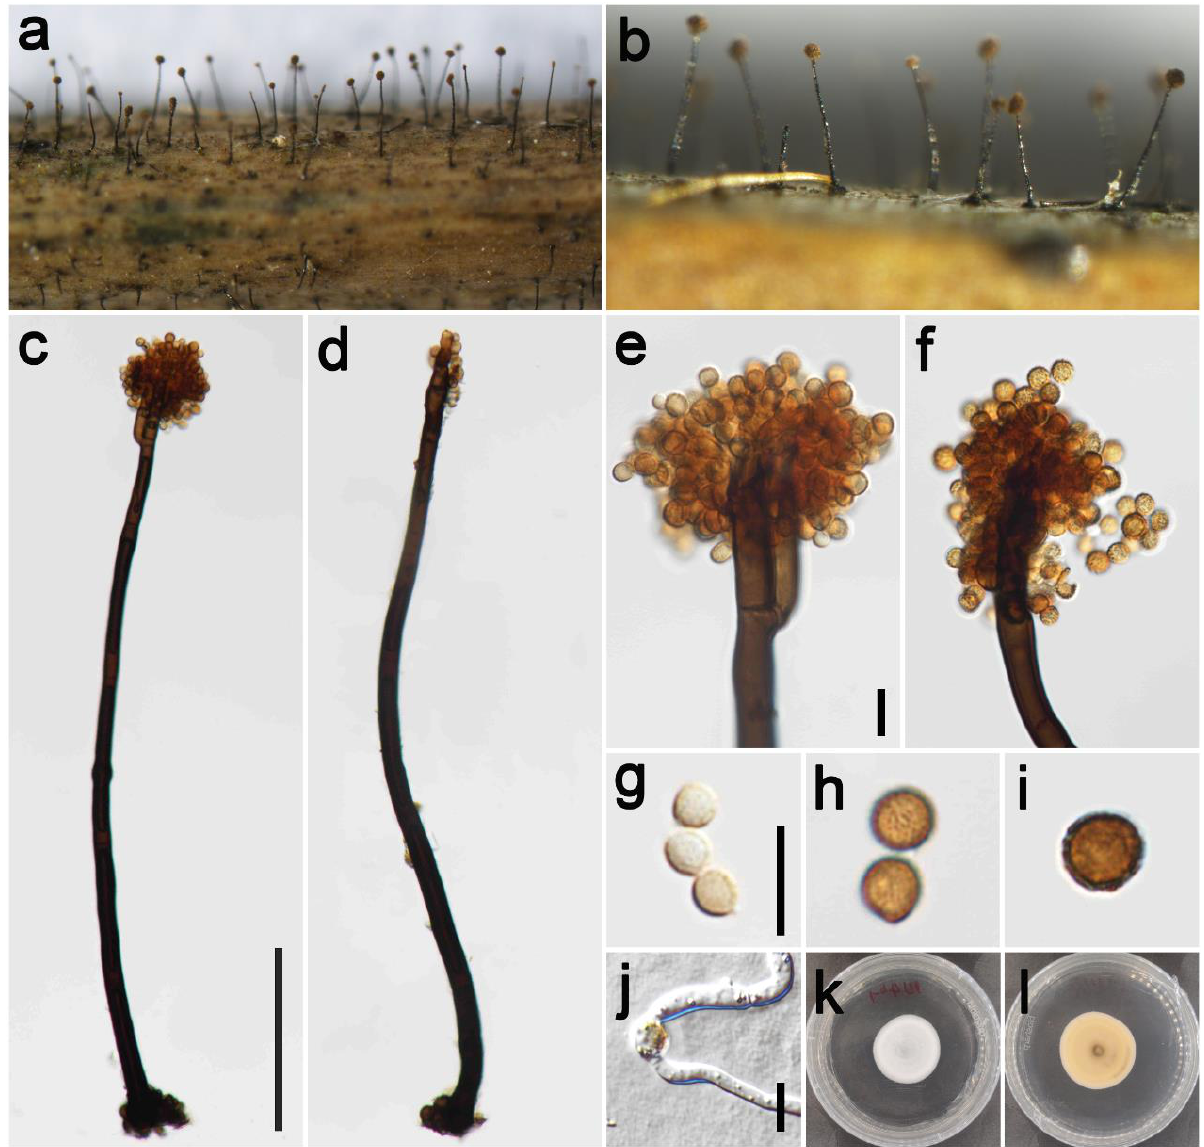
Figure 12. Periconia verrucosa (HUEST 22.0137). ( a , b ) Colonies on the natural substrate; ( c , d ) conidiophores with spherical conidial heads; ( e , f ) apically branch conidiophores with conidial head; ( g – i ) conidia; ( j ) germinating conidium; ( k , l ) colony on PDA from above and below. Scale bars: ( c ) = 100 µm, ( e , g , j ) = 10 µm . Scale bar of ( c ) applies to ( d ). Scale bar of ( e ) applies to ( f ). Scale bar of ( g ) applies to ( h – i ).